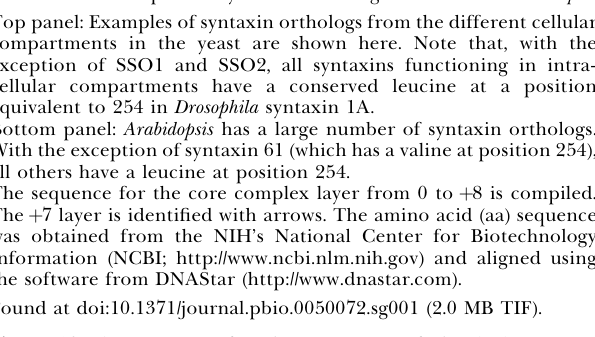
Figure S2. Optimization for the Detection of the SDS-Resistant Complex